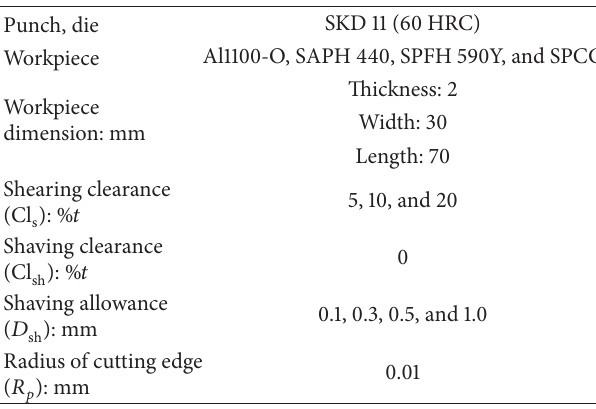
Table 3: Experimental conditions.